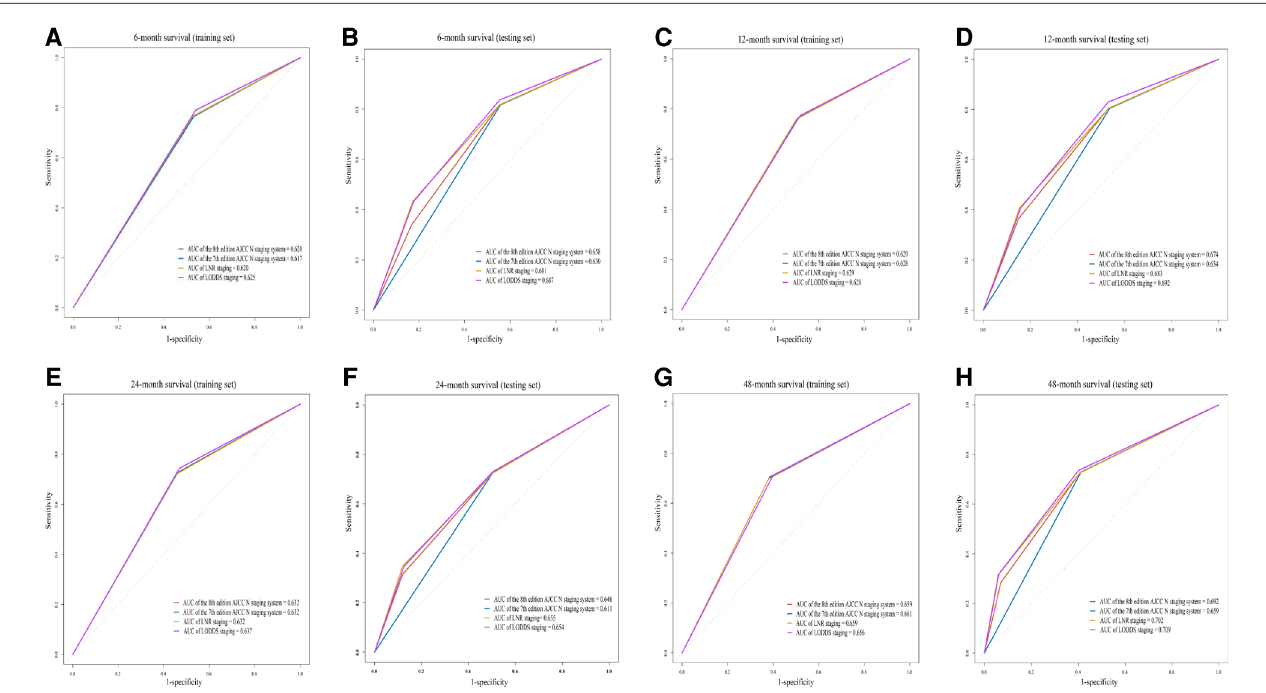
FIGURE 2 The receiver operatorcharacteristic curves (ROCs) of four staging systems (the 7th edition AJCC N staging system, the 8th edition AJCC N staging system, LNR staging and LODDS staging) predicting OS at 6 months [training set ( A ) and testing set ( B )], 12 months [training set ( C ) and testing set ( D )], 24 months [training set ( E ) and testing set ( F )] and 48 months [training set ( G ) and testing set ( H )] in patients with ACs. AUC, area under the curve; LNR staging, lymph node ratio staging; AJCC, the american joint committee on cancer; LODDS staging, the log odds of positive lymph nodes